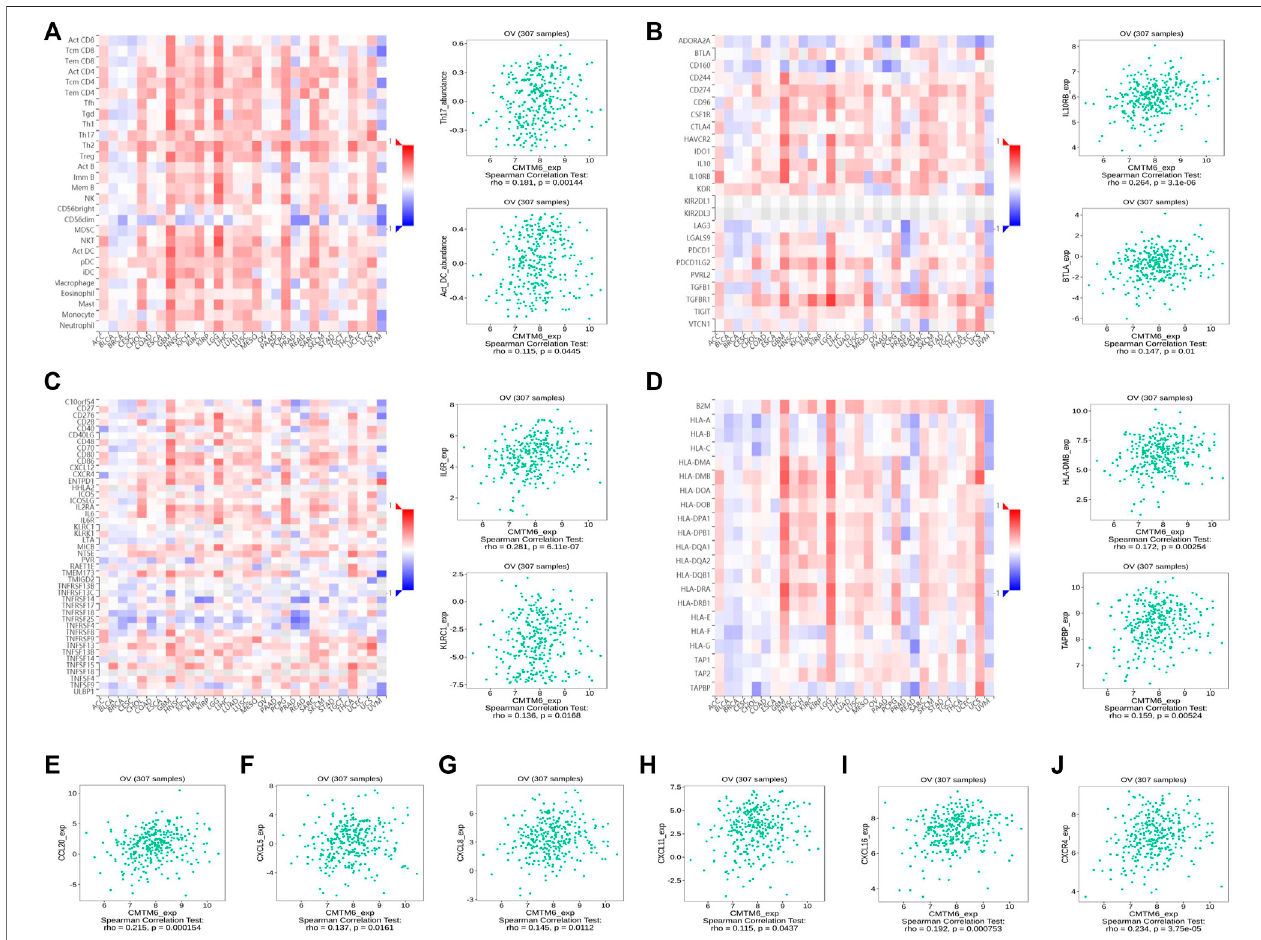
FIGURE 7 | CMTM6 expression was associated with immune in fi ltration in OV from the TISIDB database. (A – D) Spearman relations between the abundances of TILs (A) , immunoinhibitors (B) , immunostimulators (C) , and MHC molecules (D) ; the top 2 are exhibited. The relationship of CMTM6 expression with (E – I) chemokines and (J) chemokine